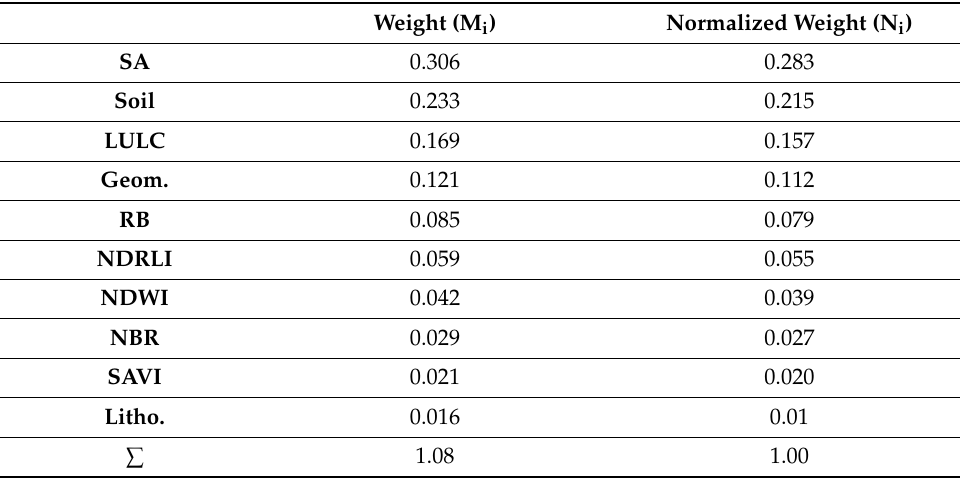
Table 7. Averaged and normalized relative weights of